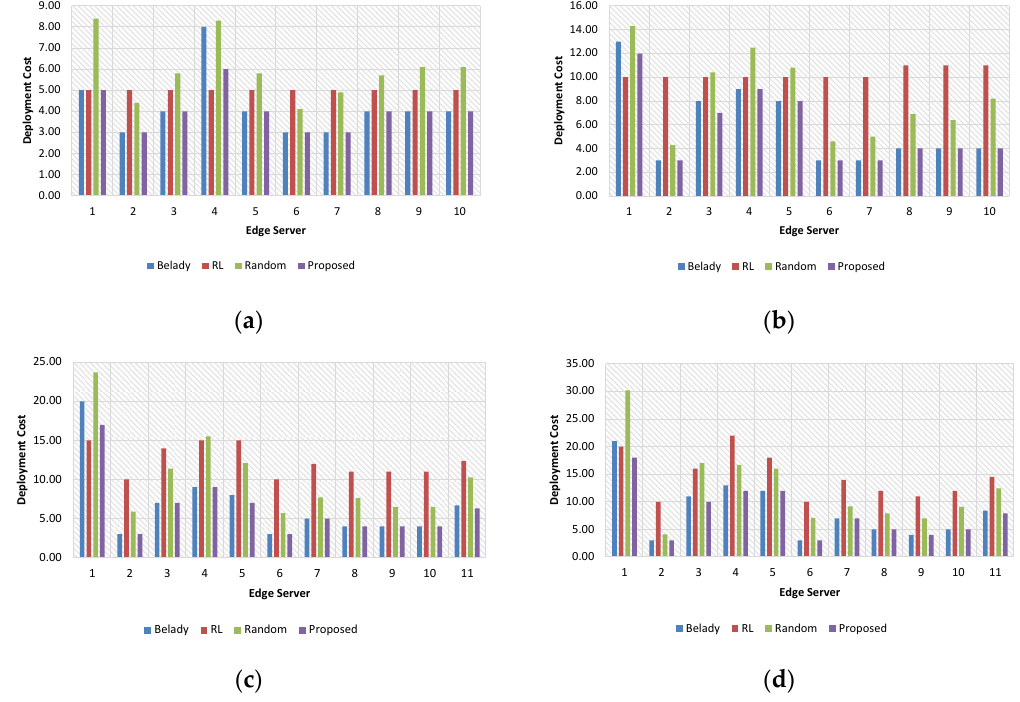
Figure 4. The results of deployment costs for the heterogeneous configuration. ( a ) Number of request: 5; ( b ) Number of request: 10; ( c ) Number of request: 15; ( d ) Number of request: 20.